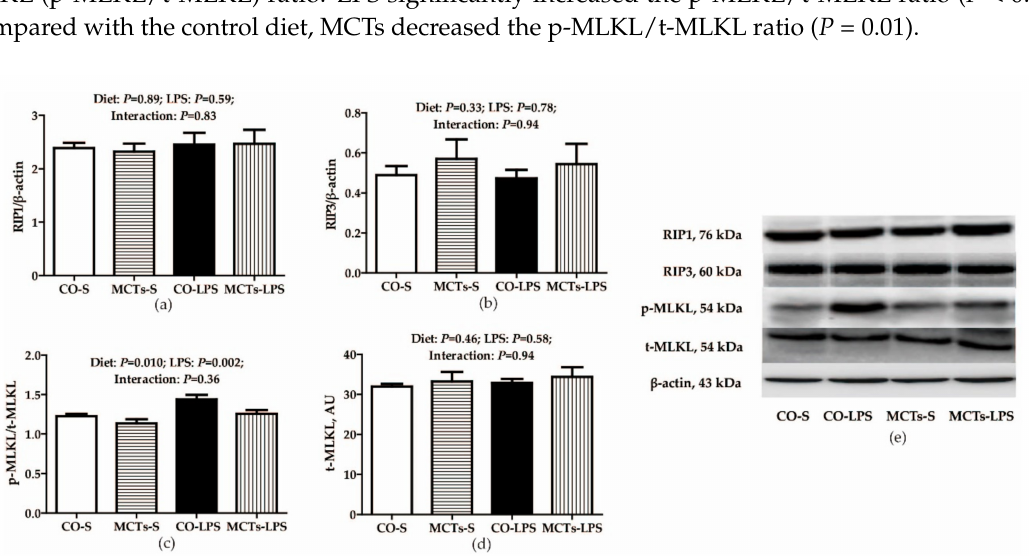
(Figure 6). No LPS challenge × diet interaction was observed for the phosphorylated MLKL/total MLKL (p-MLKL/t-MLKL) ratio. LPS significantly increased the p-MLKL/t-MLKL ratio ( P < 0.01).